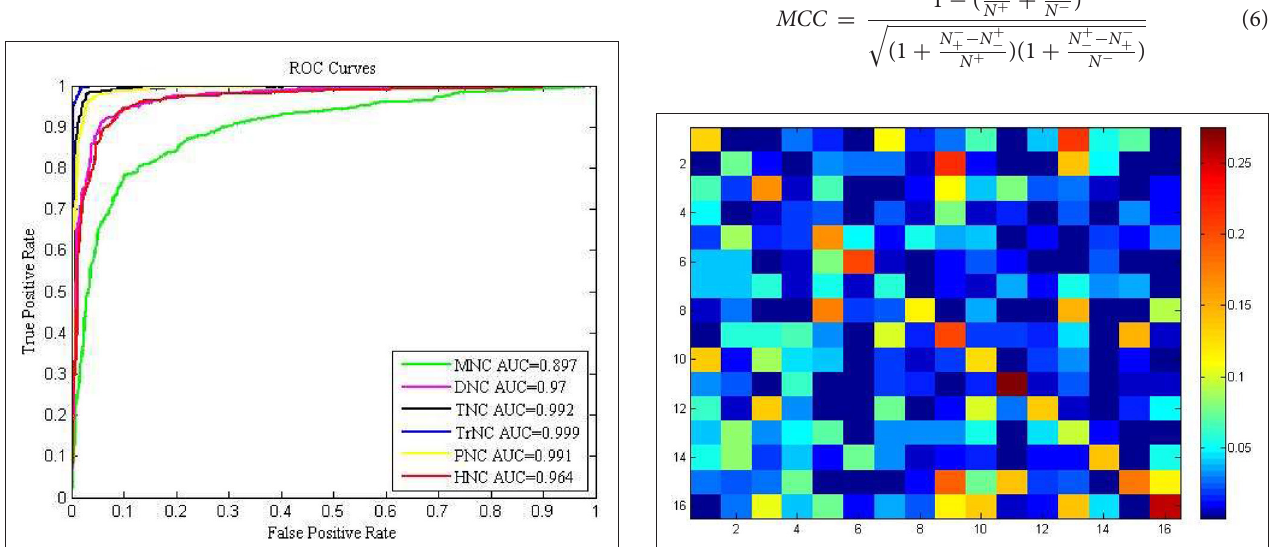
FIGURE 3 | The ROC curves to assess the predictive performance based on different feature extraction methods.